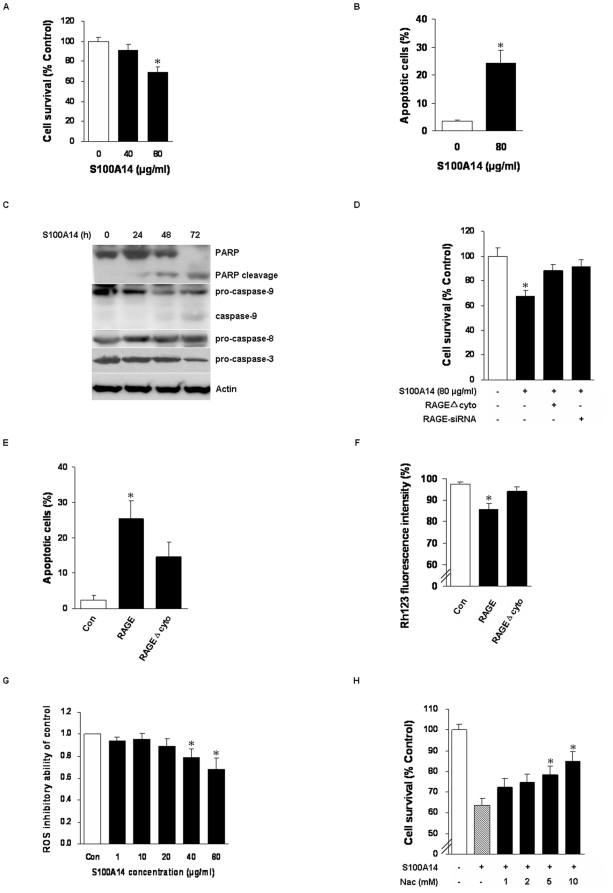
High dose of S100A14-induced apoptosis in KYSE180 cells is partially RAGE dependent.80 µg/ml S100A14 treated KYSE180 cells for 48 h significantly triggered cell injuries as detected by MTT (A) and flow cytometry assay (B). (C) KYSE180 cells were treated with 80 µg/ml S100A14 for indicated periods, then caspase-3, caspase-8, caspase-9, PARP and Actin were detected by Western Blot. (D) Inhibition of RAGE function by RAGEΔcyto or RAGE-siRNA evidently blocked 80 µg/ml S100A14-induced cell death by MTT assay. (E) Compared to KYSE180-RAGE, KYSE180-RAGEΔcyto cells had more slightly injuries with 80 µg/ml S100A14 for 48 h as detected by Annexin V-PI staining assay. (F) Cells were stained with Rh123 before flow cytometry. Data revealed the decrease of mitochondrial membrane potential in KYSE180-RAGE in contrast to KYSE180-RAGEΔcyto treated with 80 µg/ml S100A14 for 48 h (*, P<0.05). (G) High doses of S100A14 induce the generation of ROS in KYSE180 cells. Cells were treated with different doses of S100A14 for 5 h and the supernatant were used to evaluate the production of ROS. Data are expressed as means ± SD of three independent experiments (*, P<0.05). (H) Inhibition of ROS production by Nac prevented cell injuries induced by 80 µg/ml S100A14. KYSE180 cells were preincubated with the antioxidant for 24 h then exposed to S100A14 for another 24 h, MTT assay was then performed. All values represent the means ± SD of three independent experiments (*, P<0.05).